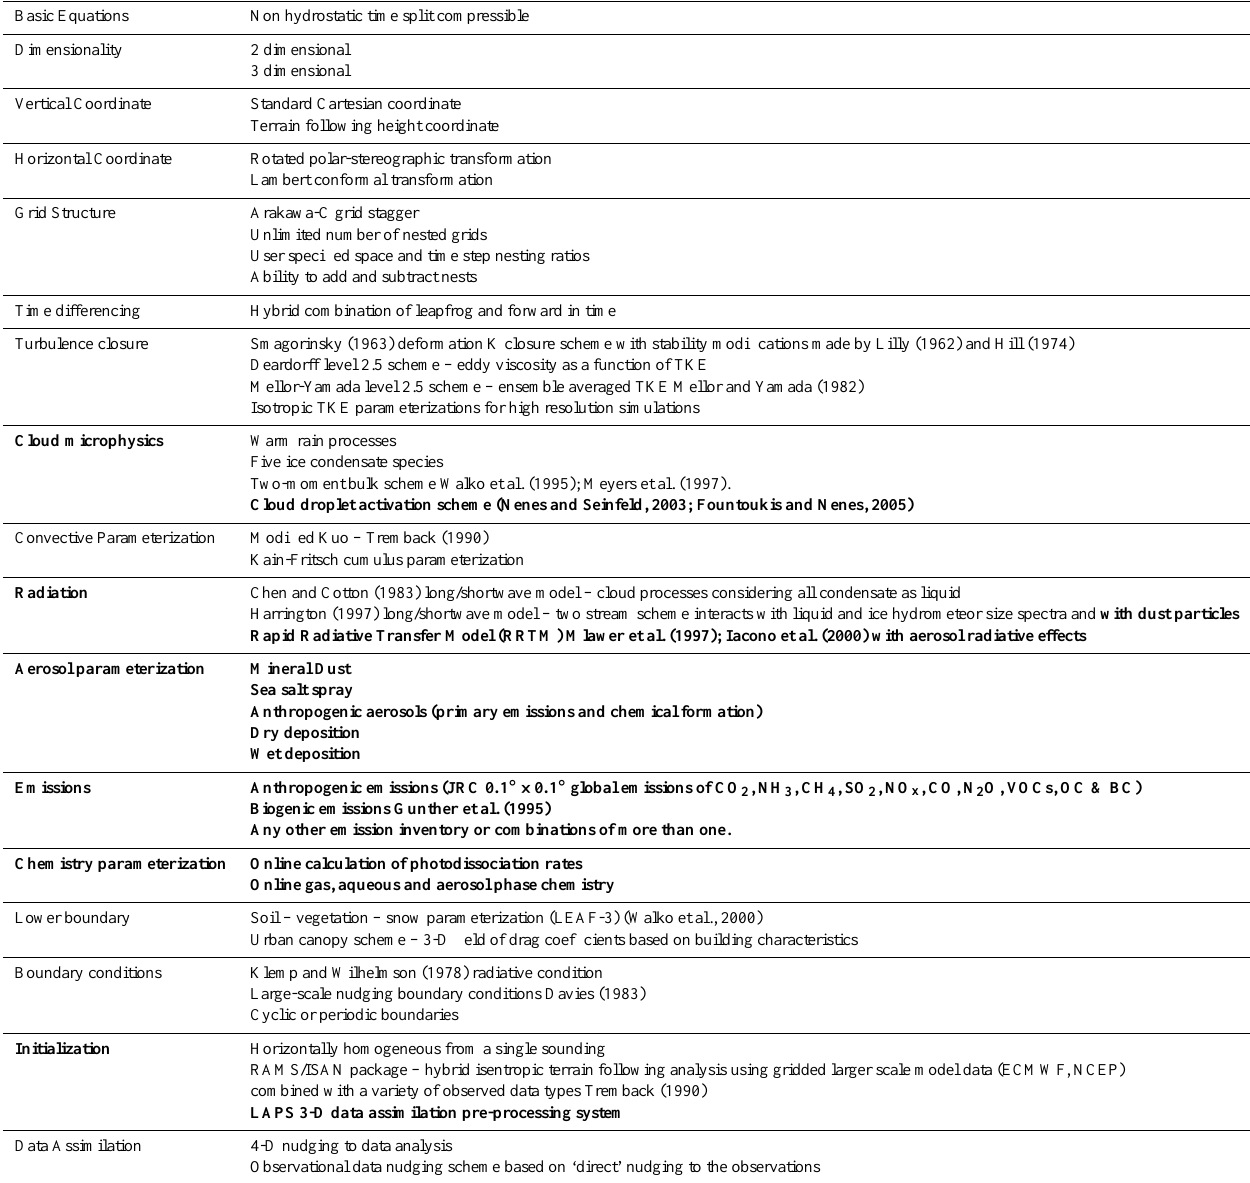
Table 1. ICLAMS configuration options. New capabilities (compared to RAMS) are shown in bold. Basic